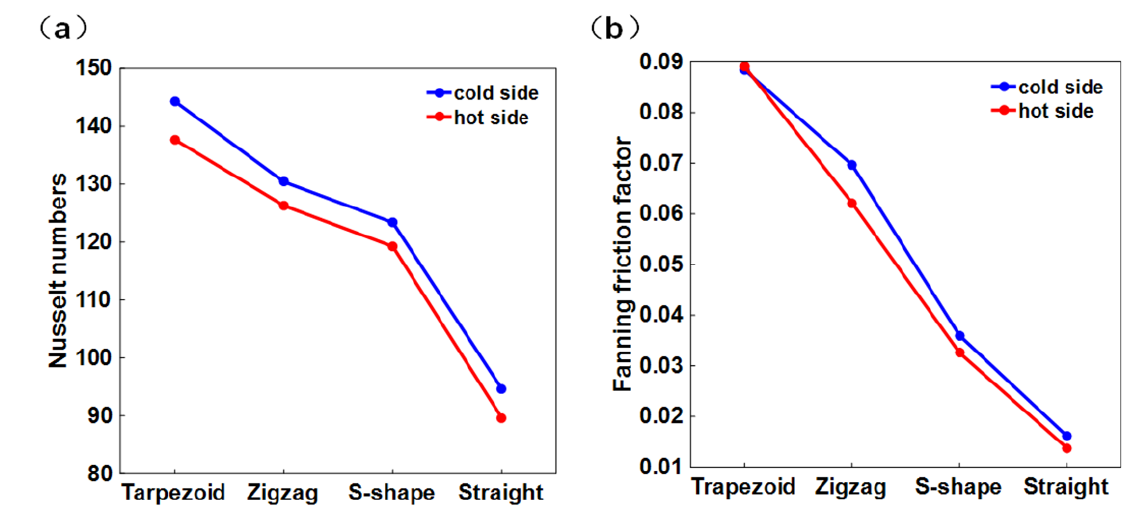
Figure 6. ( a ) The Nusselt numbers and ( b ) the Fanning friction factors of the trapezoidal, the zigzag, the S-shape, and the straight channels.